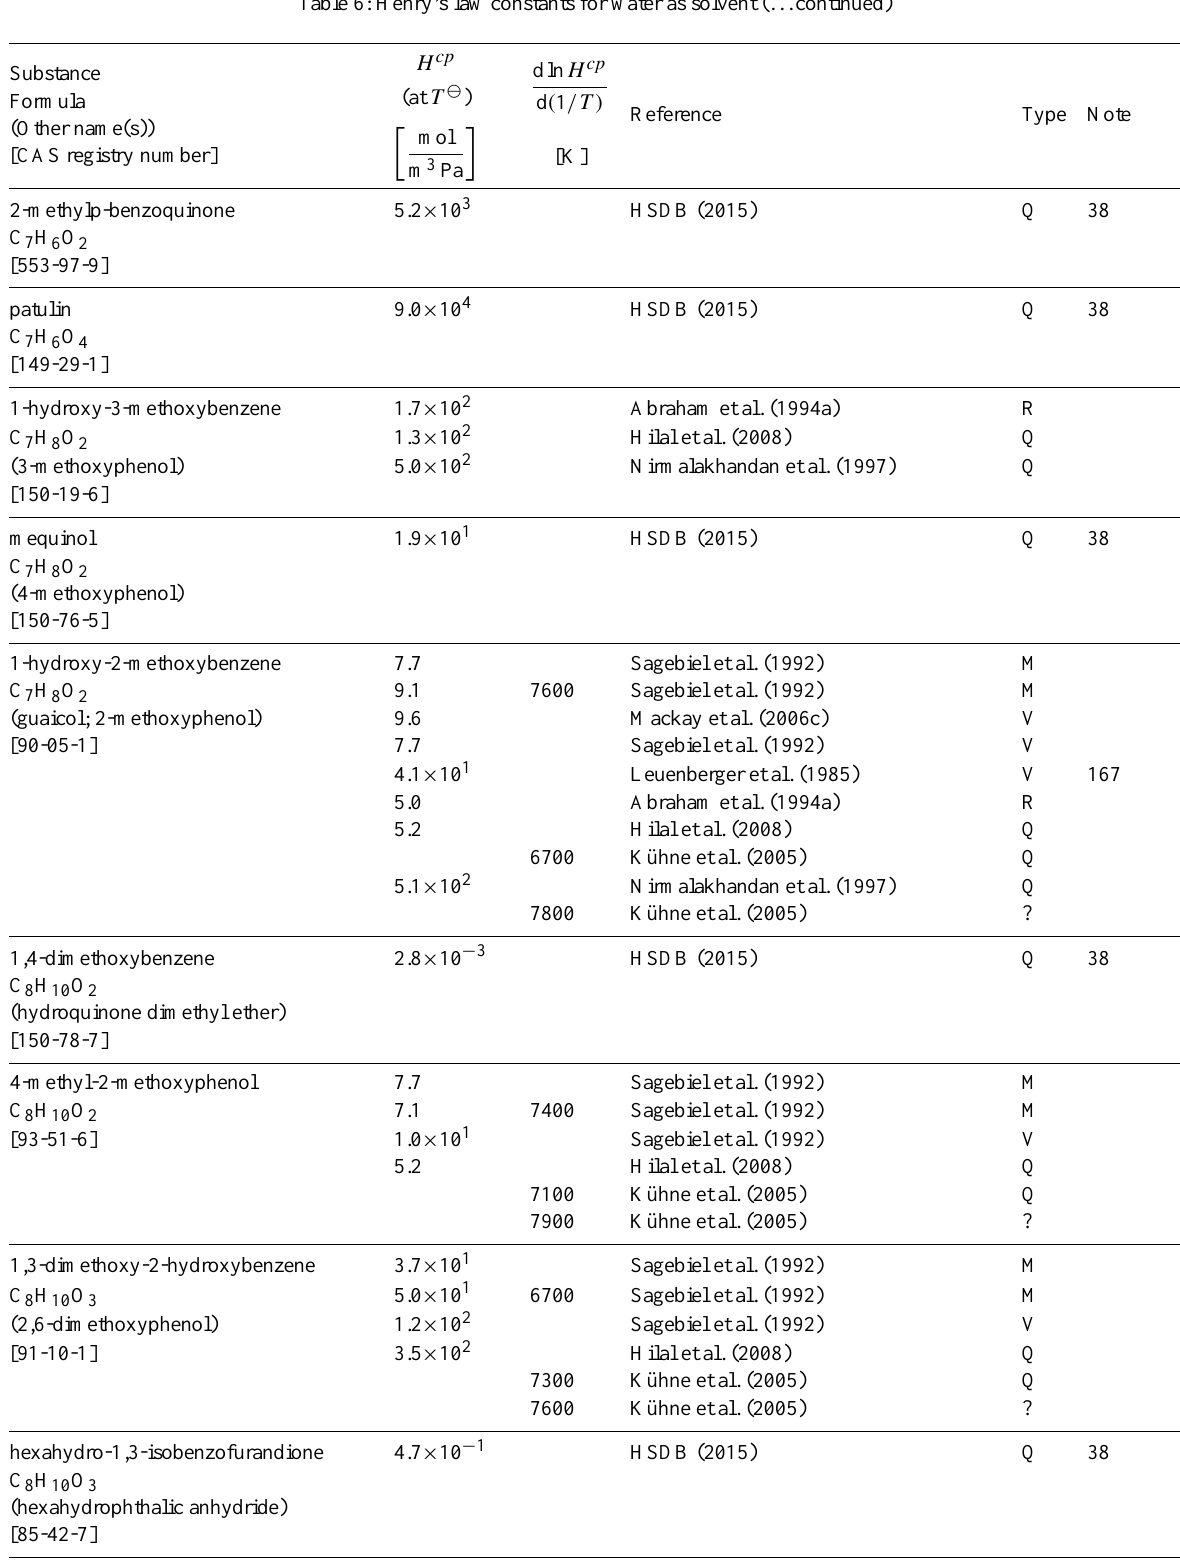
Table 6: Henry’s law constants for water as solvent